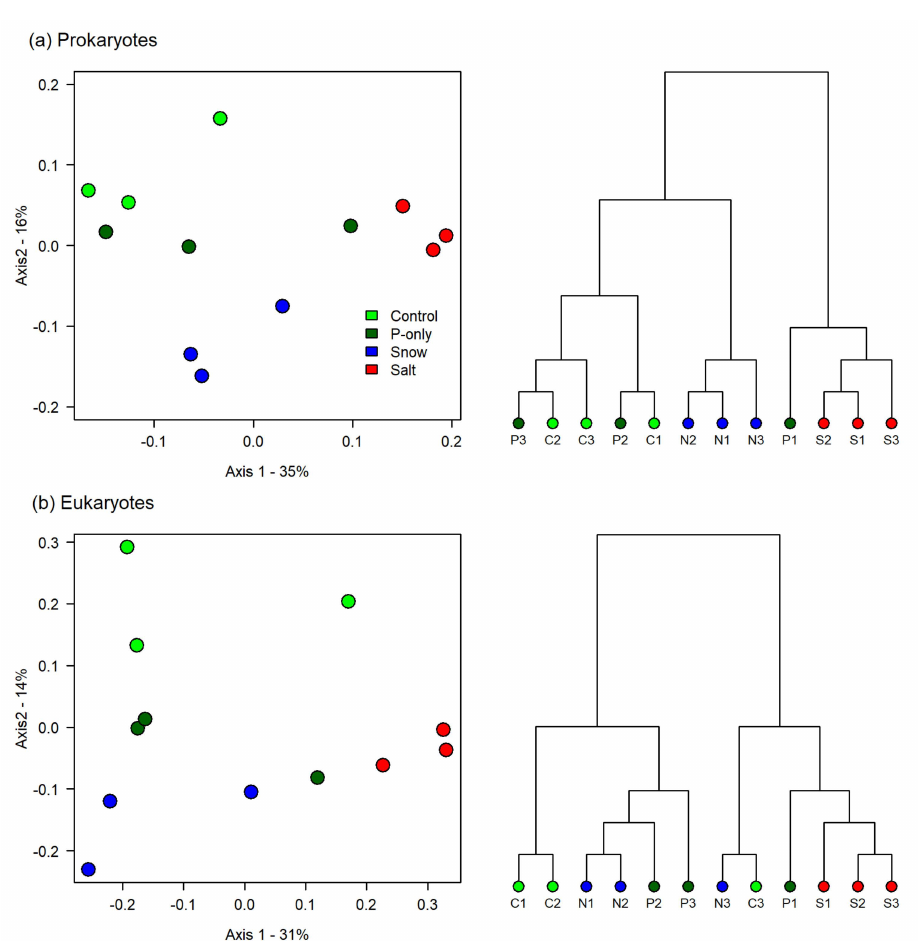
Figure 2. Principal component analysis (PCoA) for: ( a ) prokaryotes; ( b ) eukaryotes. Each point is a replicate. C = Control; P = P-Only; N = Snow; S =